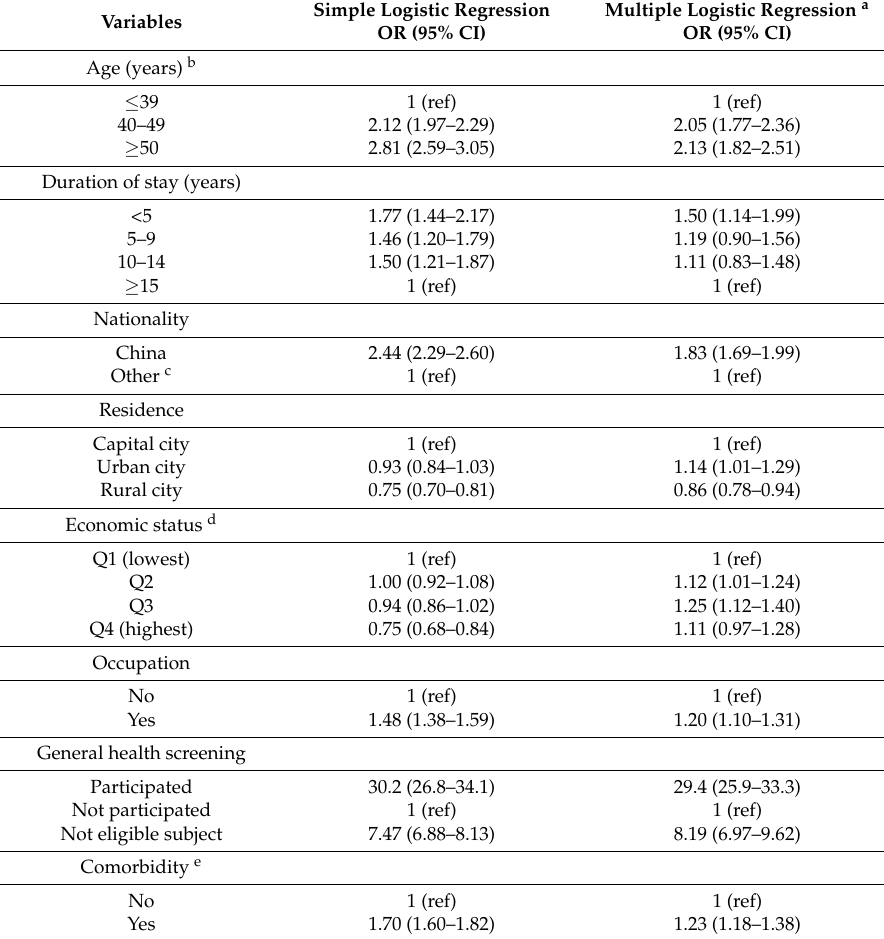
Table 2. The association between cervical cancer screening participation and related